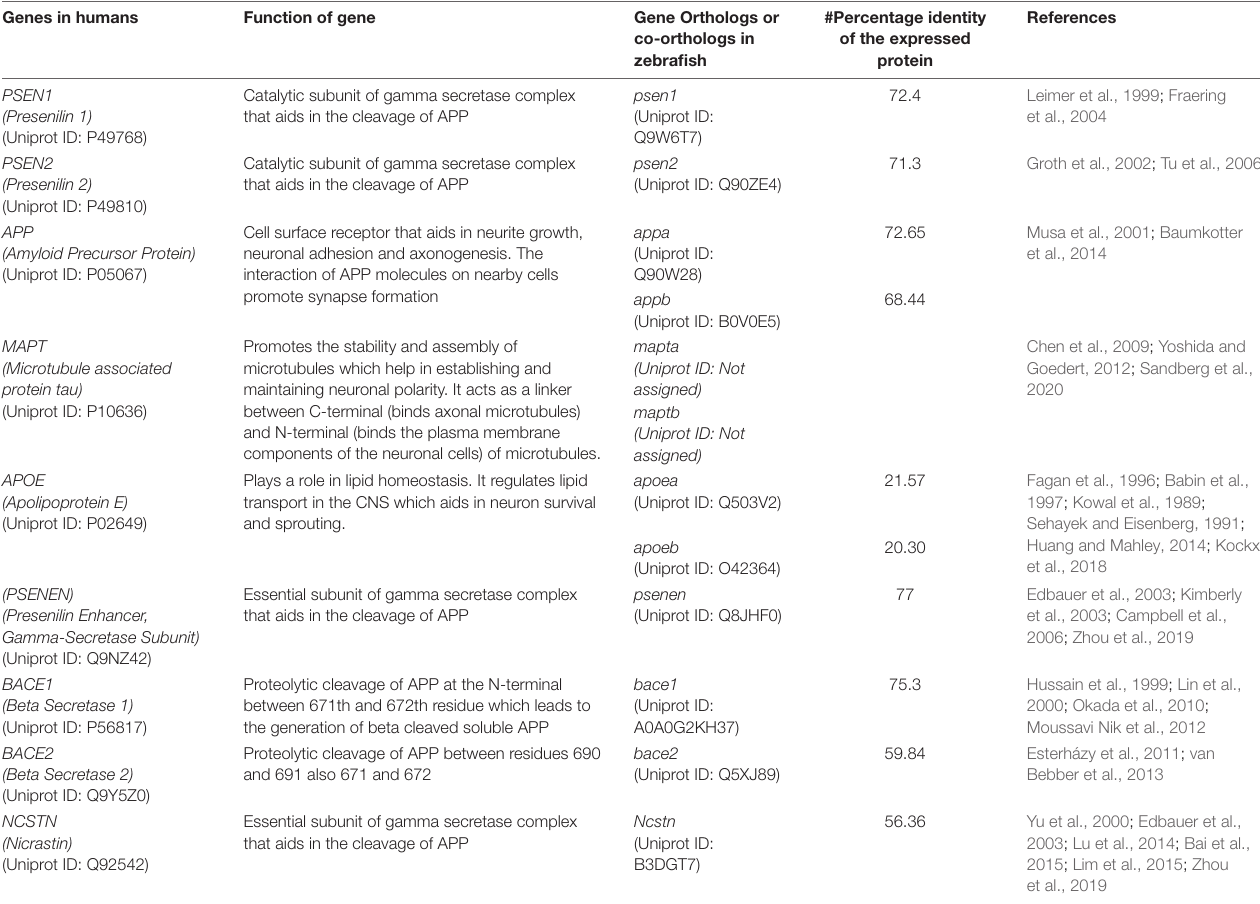
TABLE 2 | Orthologs of major human genes implicated in AD in the zebrafish. Genes in humans Function of gene Gene Orthologs or